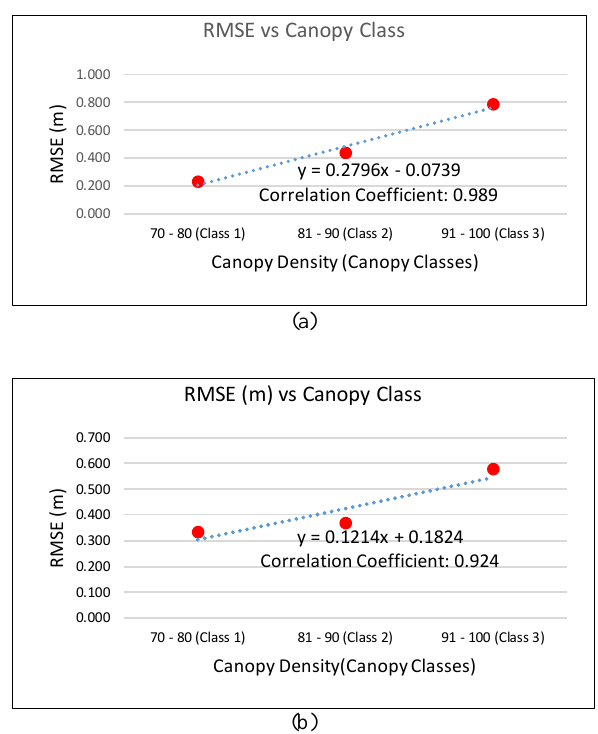
Figure 11. Graph for error of LiDAR-derived DTM associated with canopy cover over (a) rubber trees area, and (b) mixed-forest